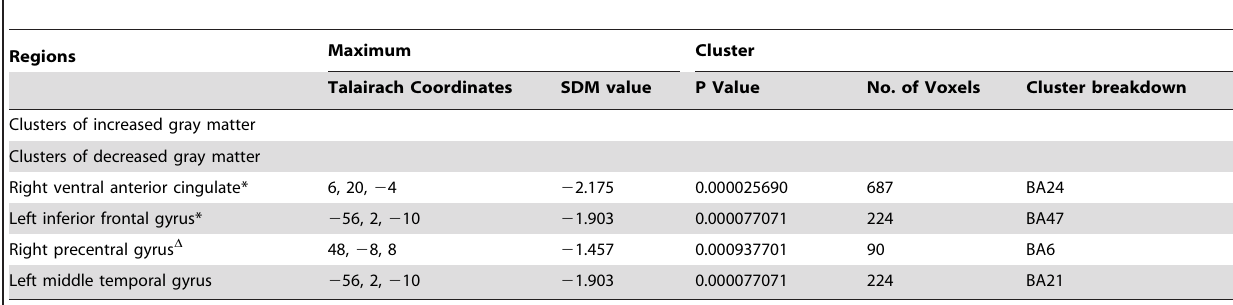
Table 3. Regions With Significant Differences In Gray Matter Volumes Between Patients With Anxiety Disorders Without Comorbid Depression And Healthy